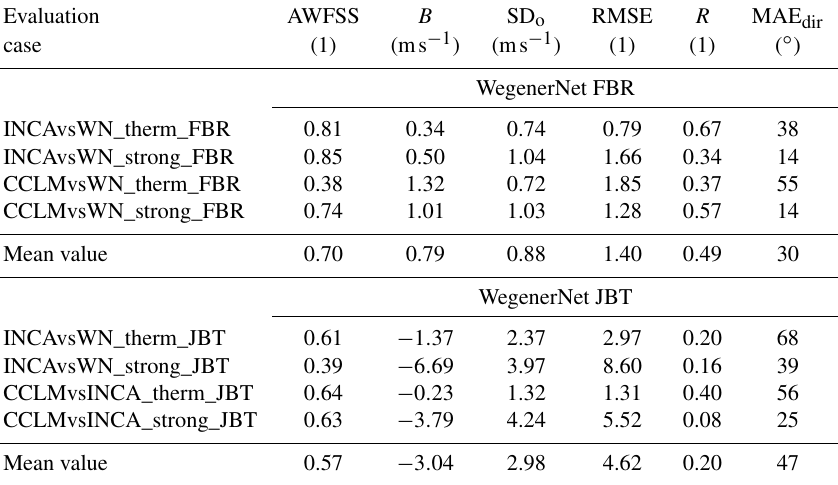
Table 4. Statistical performance measures calculated for the evaluation cases from Table 1, for the WegenerNet FBR and the WegenerNet JBT region. See Table 3 for more information on the calculation of the